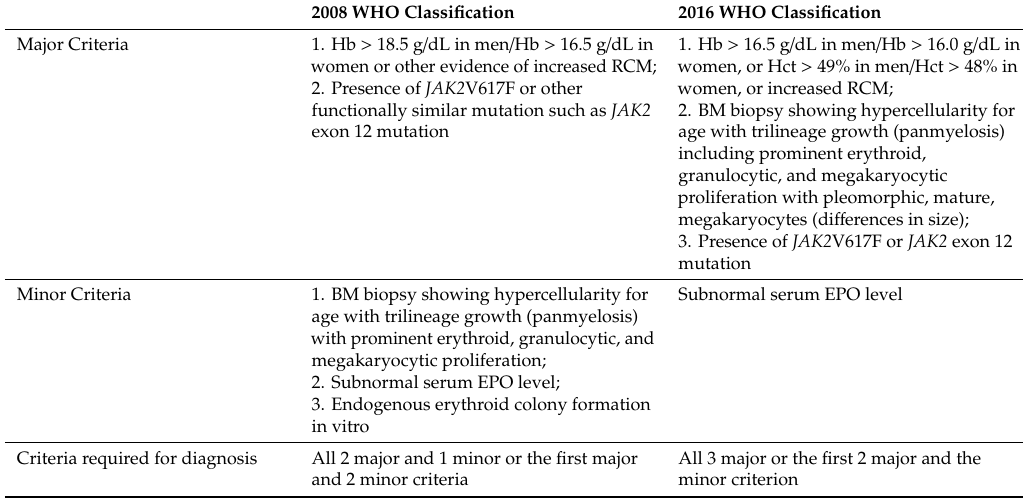
Table 1. Diagnostic criteria for polycythemia vera according to the World Health Organization (WHO) classification.